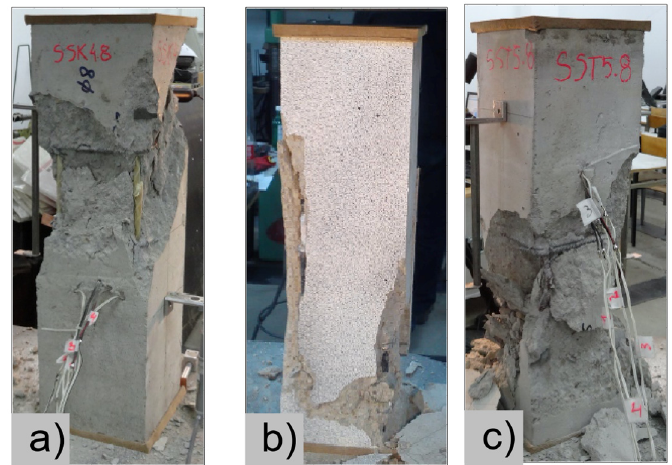
Figure 6. Typical forms of damage, specimens: ( a ) G8, ( b ) B8, ( c ) S8.